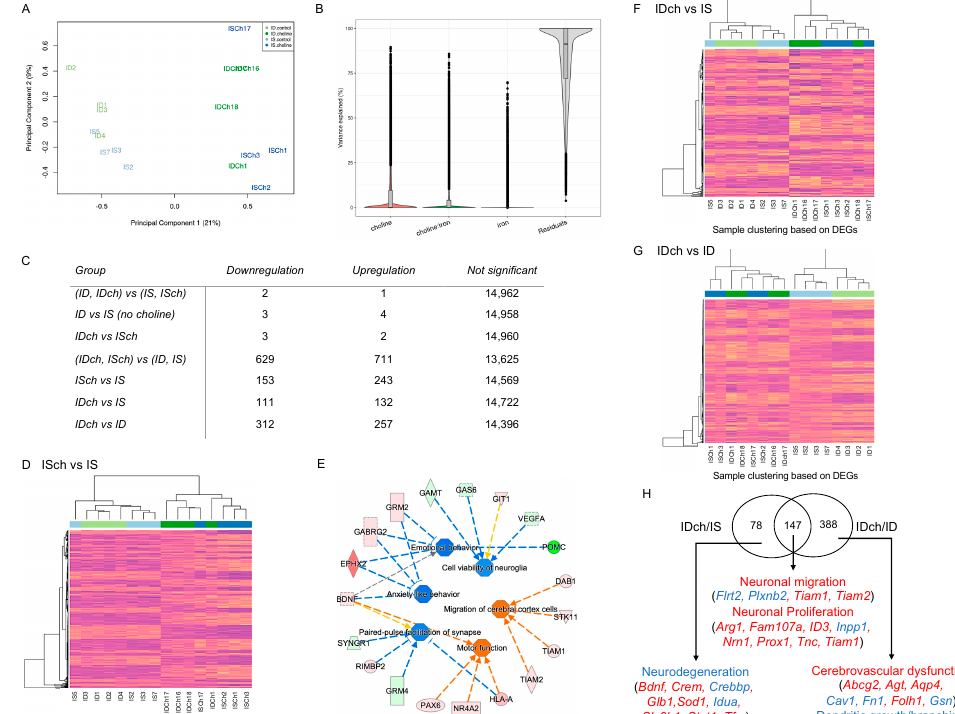
Figure 2. Effects of choline supplementation and ID on the female hippocampal transcriptome. ( A ) Multidimensional plot showing a clear separation between choline − supplemented and non − supplemented groups, but not with iron status. ( B ) Analysis of variance shows that choline and choline ‐ by ‐ iron interaction can account for changes in gene expression. ( C ) Table showing gene expression changes among comparison groups. ( D ) Heatmap of DE genes from ISch vs. IS comparison showing clear clustering between choline ‐ supplemented and non ‐ supplemented groups. ( E ) IPA annotated functional changes based on DE genes between ISch vs. IS comparison. Blue = Inhibition, Orange = Activation, Yellow = Finding inconsistent with the state of the downstream molecule, Grey = Finding not predicted, Solid and Dashed arrows = direct and indirect interactions, Green − to − Red = Downregulated ‐ to ‐ Upregulated genes. ( F , G ) Heatmaps showing distinct clustering of choline ‐ treated samples using DE genes in IDch vs. IS or ID groups. ( H ) IPA analysis of overlapping DE genes between IDch vs. IS and IDch vs. ID groups showing the rescue effects of choline treatment on specific biological activities. In heatmaps, each bar represents gene expression in CPM, with purple being the lowest expression value and yellow being the highest. Blue and green bars at the top indicate the group assignment.